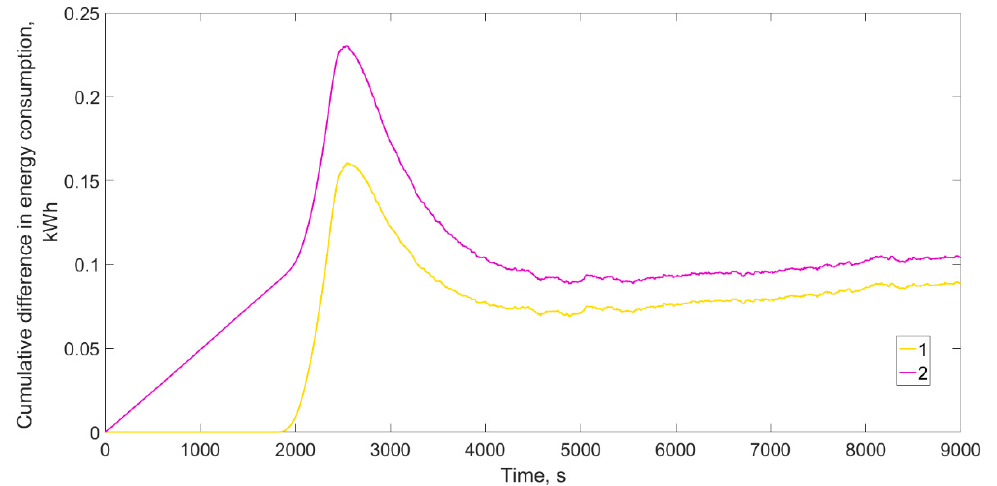
Figure 17. Course of the cumulative energy usage difference for control systems with a noise of 3%: 1—(relay—PID) and 2—(relay—I-PD).